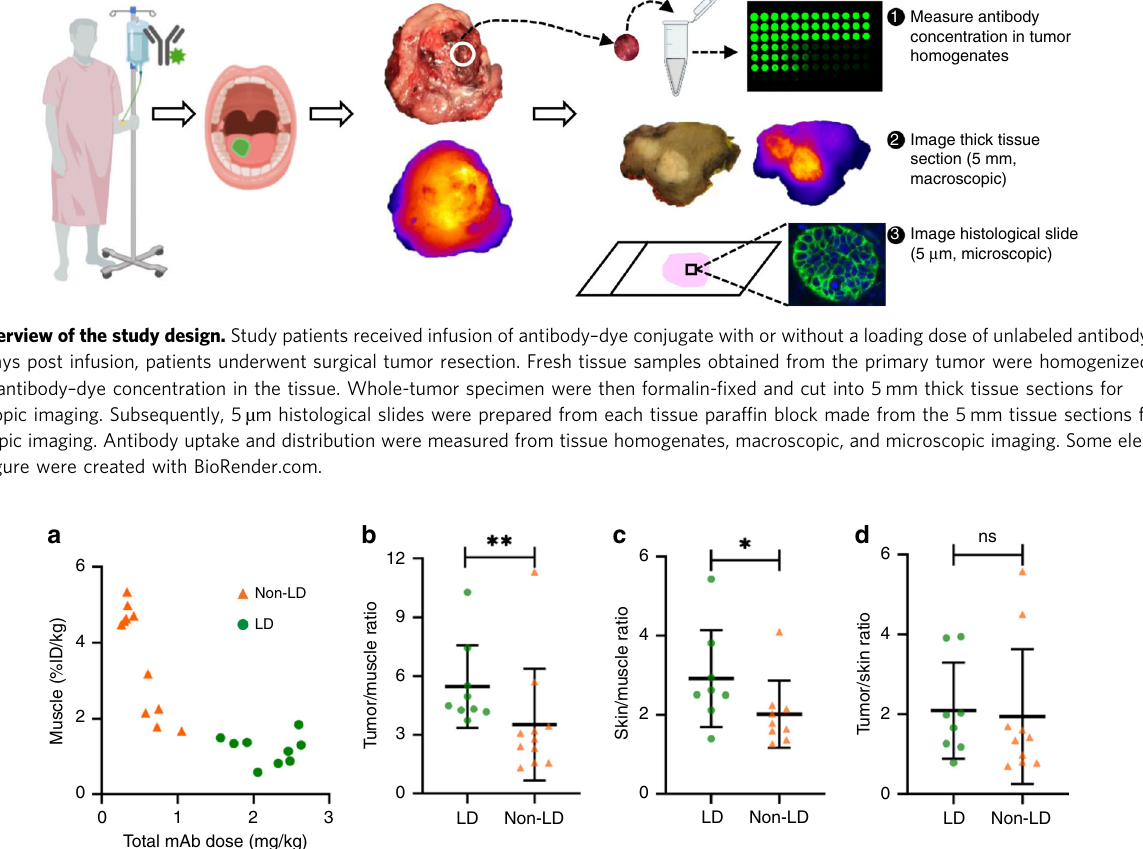
Fig. 2 Co-administration of unlabeled antibody reduced muscle uptake while maintained tumor uptake. a Muscle antibody uptake (%ID kg − 1 : percent injected dose per kilogram) decreased with increasing total monoclonal antibody (mAb) dose (owing to loading dose (LD)). b , c . Tumor and skin uptake (% ID kg − 1 ) as normalized by muscle uptake (%ID kg − 1 ) were signi fi cantly higher in the loading dose group than that in the non-loading dose group, suggesting that tumor and skin were not fully saturated within the total antibody dose range of 0.3 mg kg − 1 to 2.6 mg kg − 1 . d When tumor uptake was normalized by skin uptake, there was no signi fi cant differences between groups. The number of independent patient samples available in b : n = 9 (LD), n = 11 (non-LD); c n = 8 (LD), n = 9 (non-LD); d n = 8 (LD), n = 10 (non-LD). p value = 0.010 b , 0.046 c . Mann – Whitney U test (two-tailed) were used for comparison in b – d . Graphs plotted mean with standard deviation. (* p < 0.05. ** p < 0.01, ns: p >